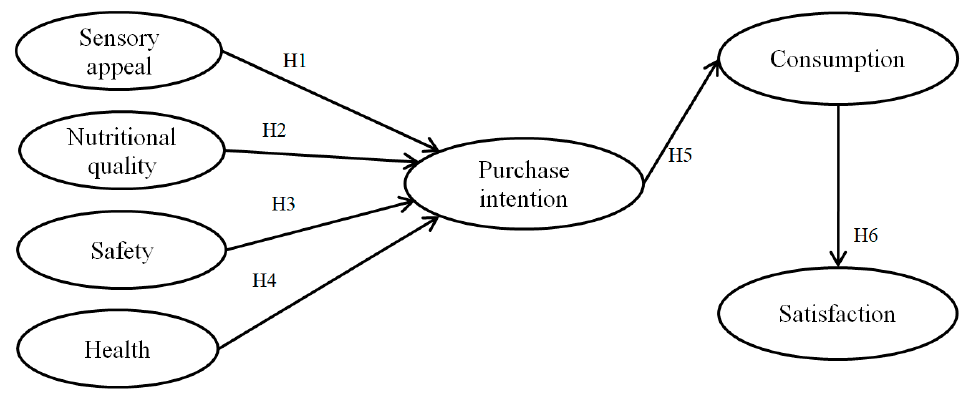
Figure 1. Conceptual model.